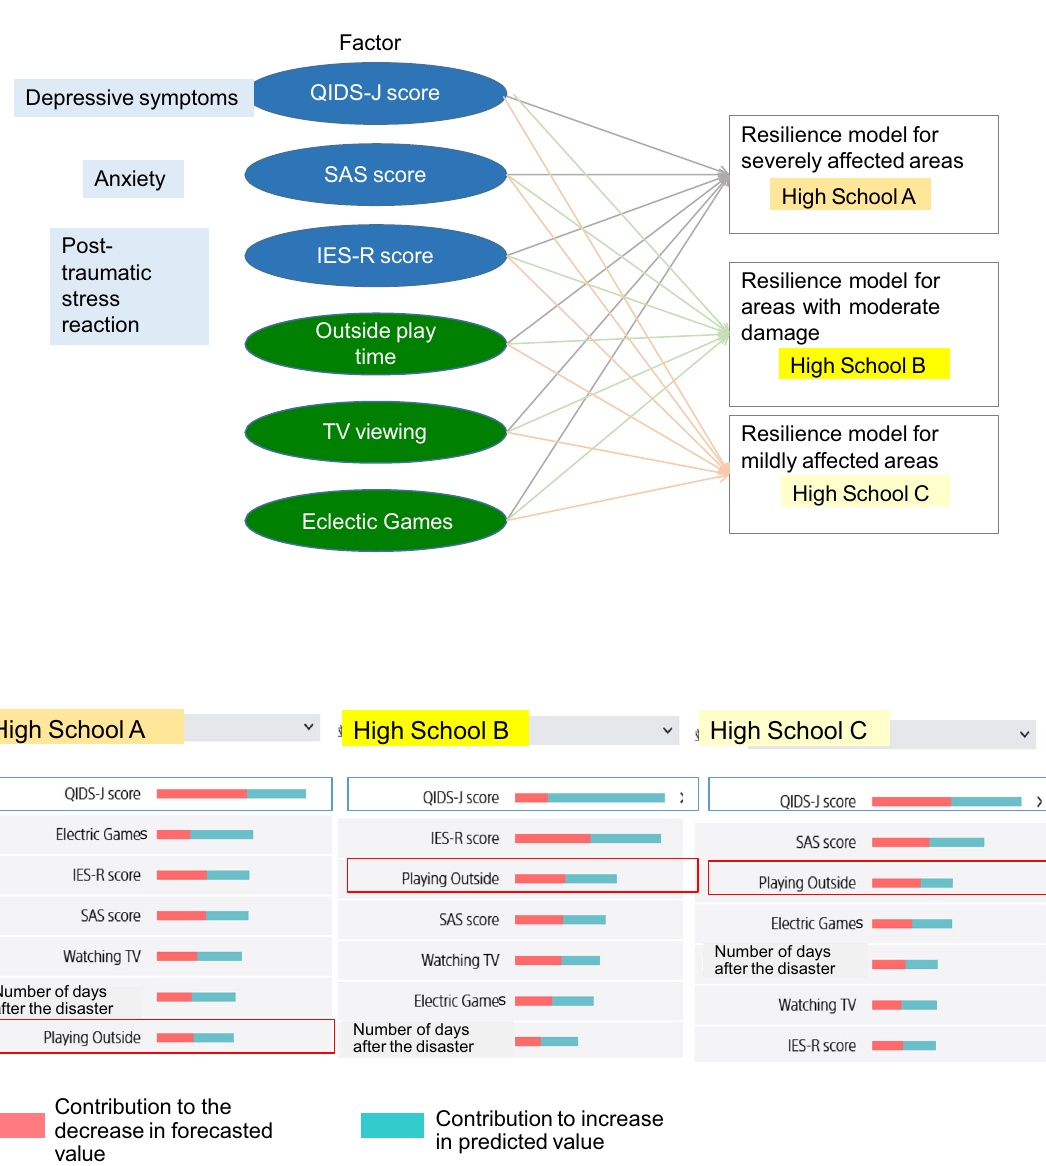
Fig. 5 Factors contributing to resilience after the Great East Japan Earthquake. QIDS-J Quick Inventory of Depressive Symptomatology — Japanese version; SAS Zung Self-Rating Anxiety Scale, IES-R Impact of Event Scale — Revised, CD-RISC-10 10-item Conner-Davidson Resilience